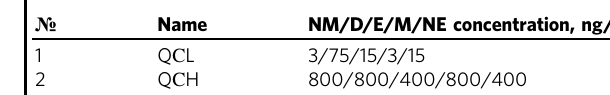
Table 2 Composition of quality control